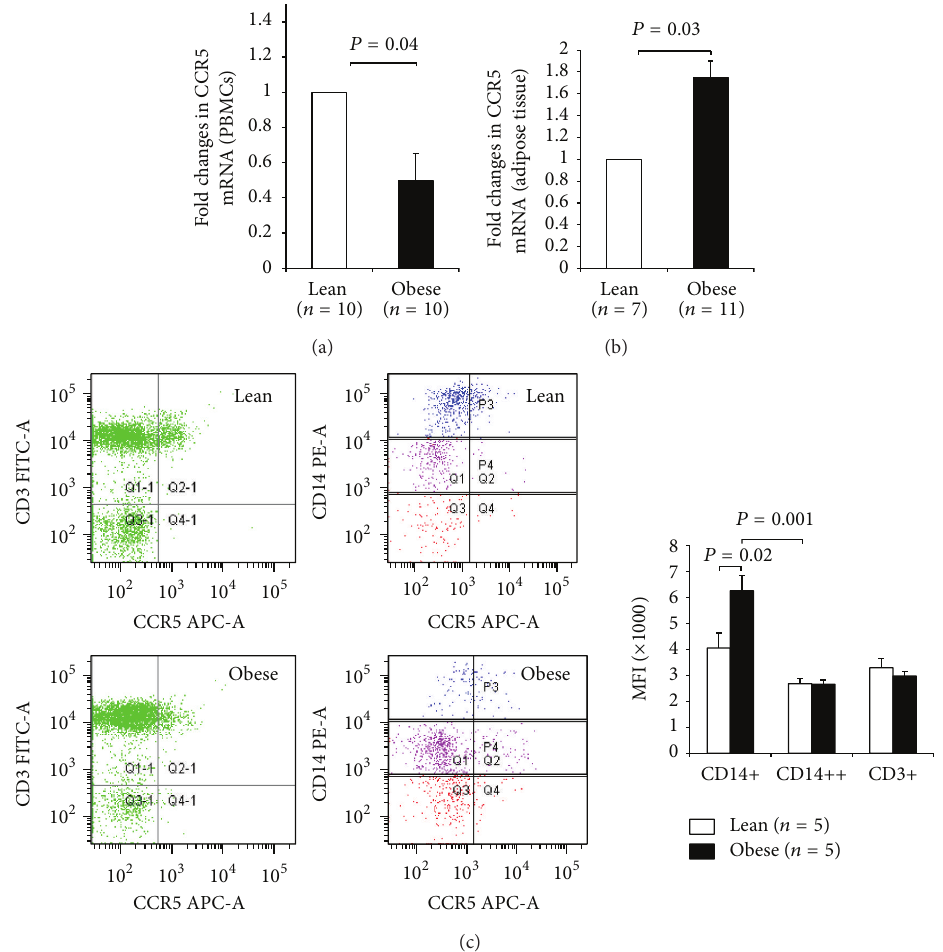
Figure 3: Differential regulation of CCR5 in PBMCs and adipose tissue is associated with obesity. CCR5 gene expression was measured by qRT-PCR in PBMCs (a) from lean and obese nondiabetic subjects and in the adipose tissue (b) from lean and obese nondiabetic subjects. The data are presented as fold changes in obese compared to lean subjects after normalization with the GAPDH reference gene. (c) Characterization of the monocyte subpopulations and T cells in peripheral blood from lean and obese subjects. Monocytes subsets were defined by staining for CD14 (PE), T cells by CD3 (FITC), and expression of CCR5 (APC) and then were analyzed. Gates P4 and P3 define the CD14+ and CD14++ subsets, respectively. Left and right upper panels are representative dot plots of CD3 and CCR5 expression on T cells from lean and obese subjects, respectively. Left and right lower panels are representative dot plots of CD14 and RANTES expression on monocyte subsets from lean and obese participants, respectively. The double-positive populations (i.e., CD3+CCR5+, CD14+CCR5+, and CD14++CCR5+) were analyzed for mean CCR5 fluorescence intensity. For each experiment, the sample size from each group is indicated by 𝑛